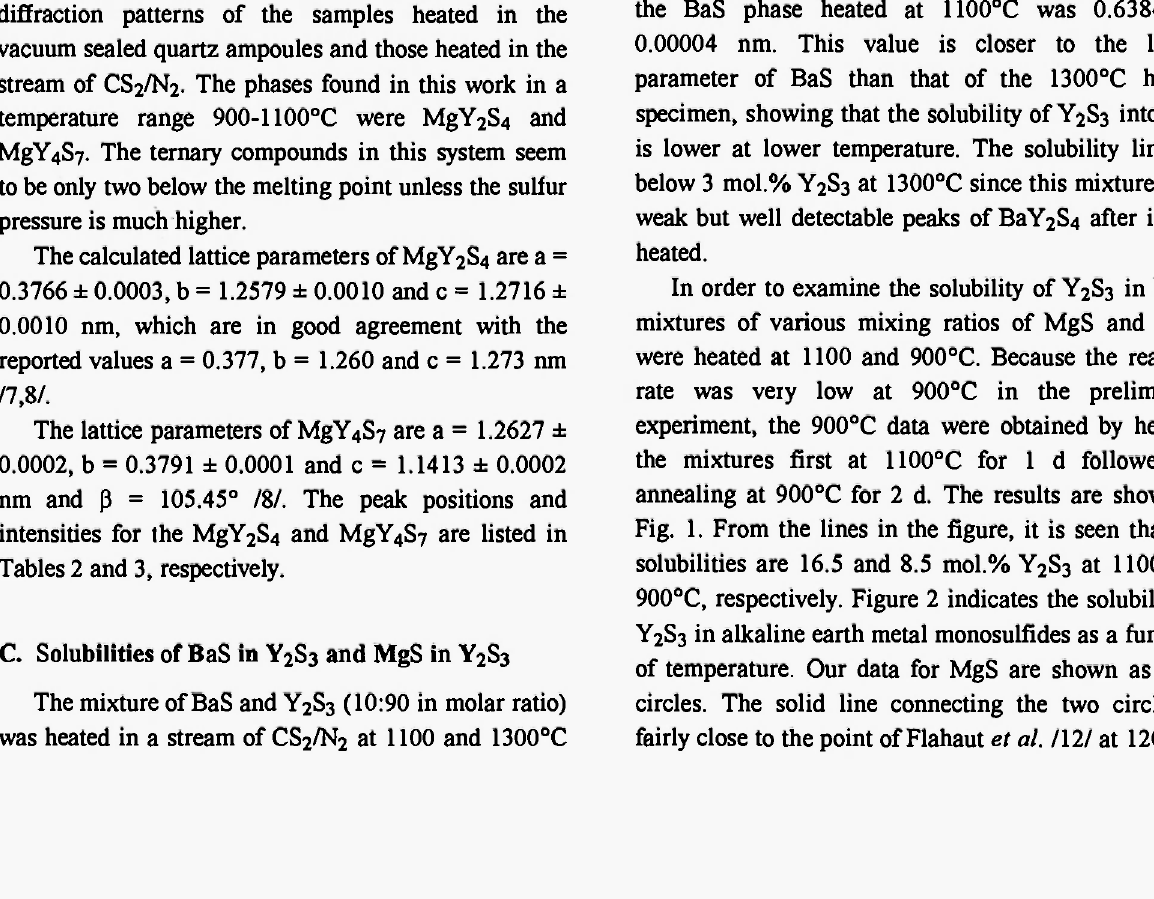
900°C, respectively. Figure 2 indicates the solubility of Y2S3 in alkaline earth metal monosulfides as a function of temperature. Our data for MgS are shown as open circles. The solid line connecting the two circles is fairly close to the point of Flahaut et al. /12/ at